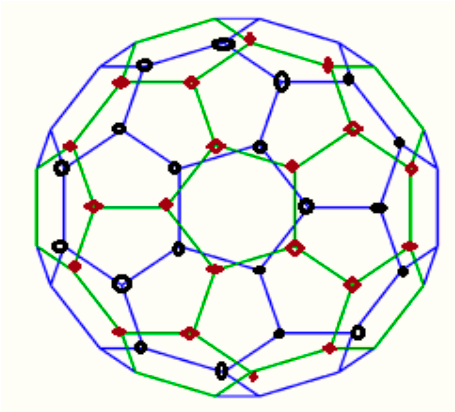
Figure 8. Temperature tracing strategy using DA.